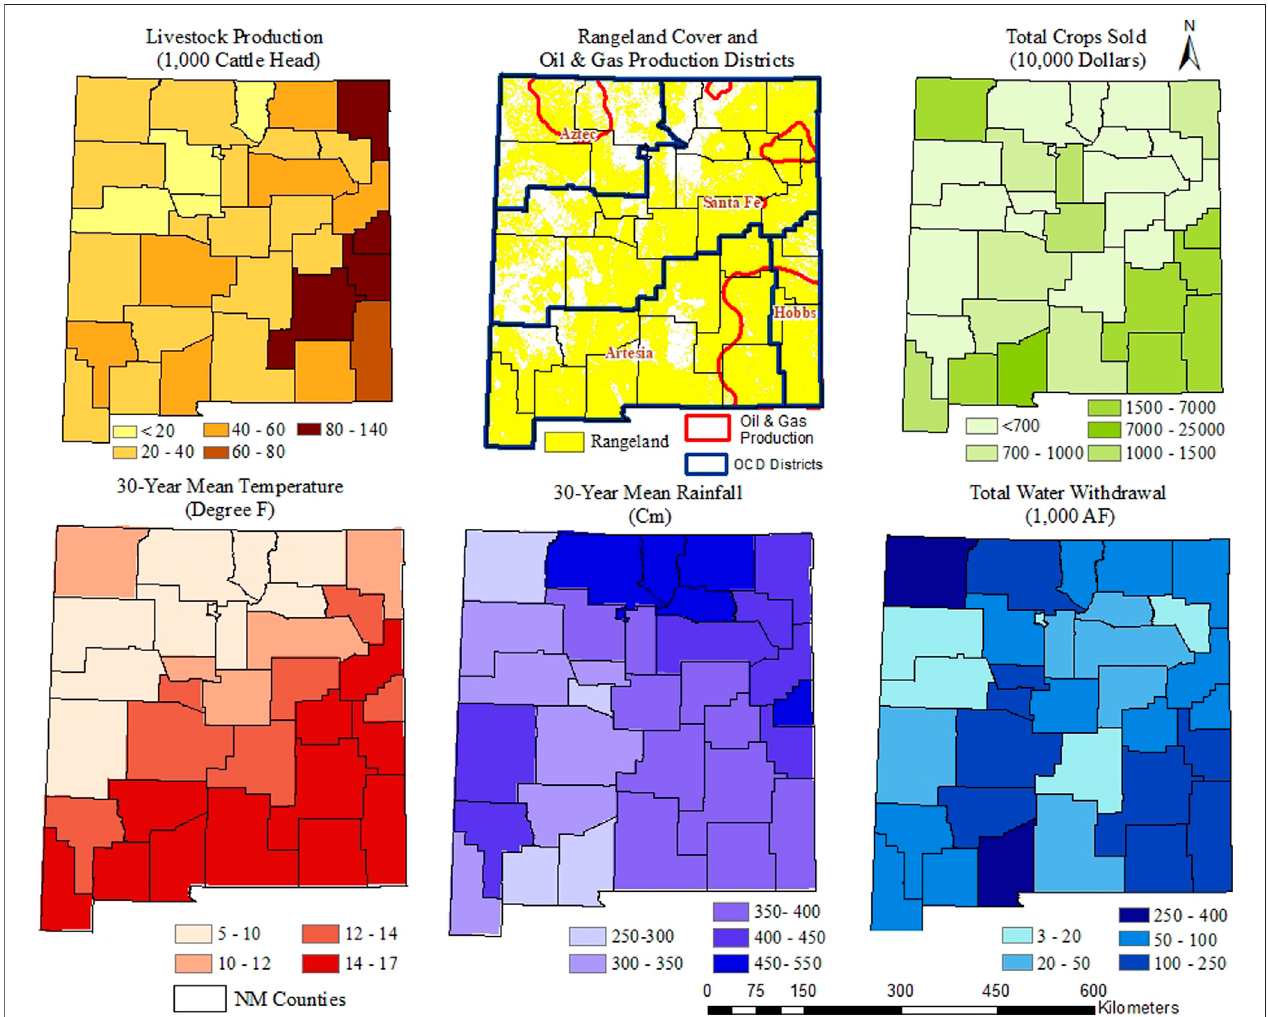
FIGURE 1 | Study area showing county-wise distribution of food – energy – water systems and climate over New Mexico that includes livestock production (NASS, 2015), rangeland cover (USFS, 2019), total crops sold (NASS, 2015), total water withdrawal (Molly et al., 2015), Oil & Gas production in Oil Conservation Division (OCD) Districts, and 30-year (1981 – 2010) mean annual temperature and rainfall (PRISM,